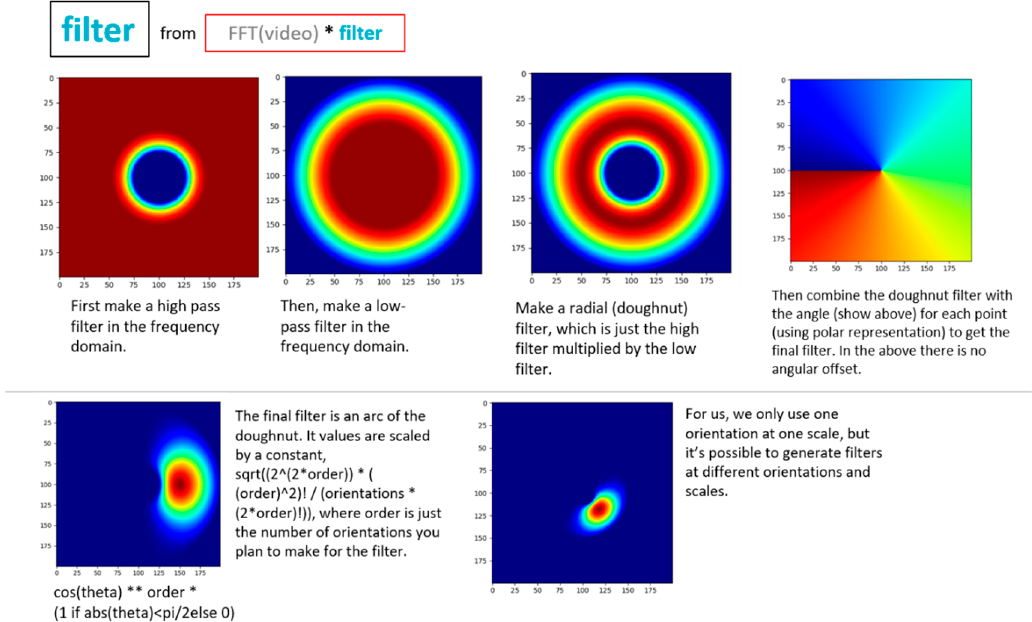
Figure 4. Overview of process for building filter to perform phase-based optical flow [22,52,53,57–59].